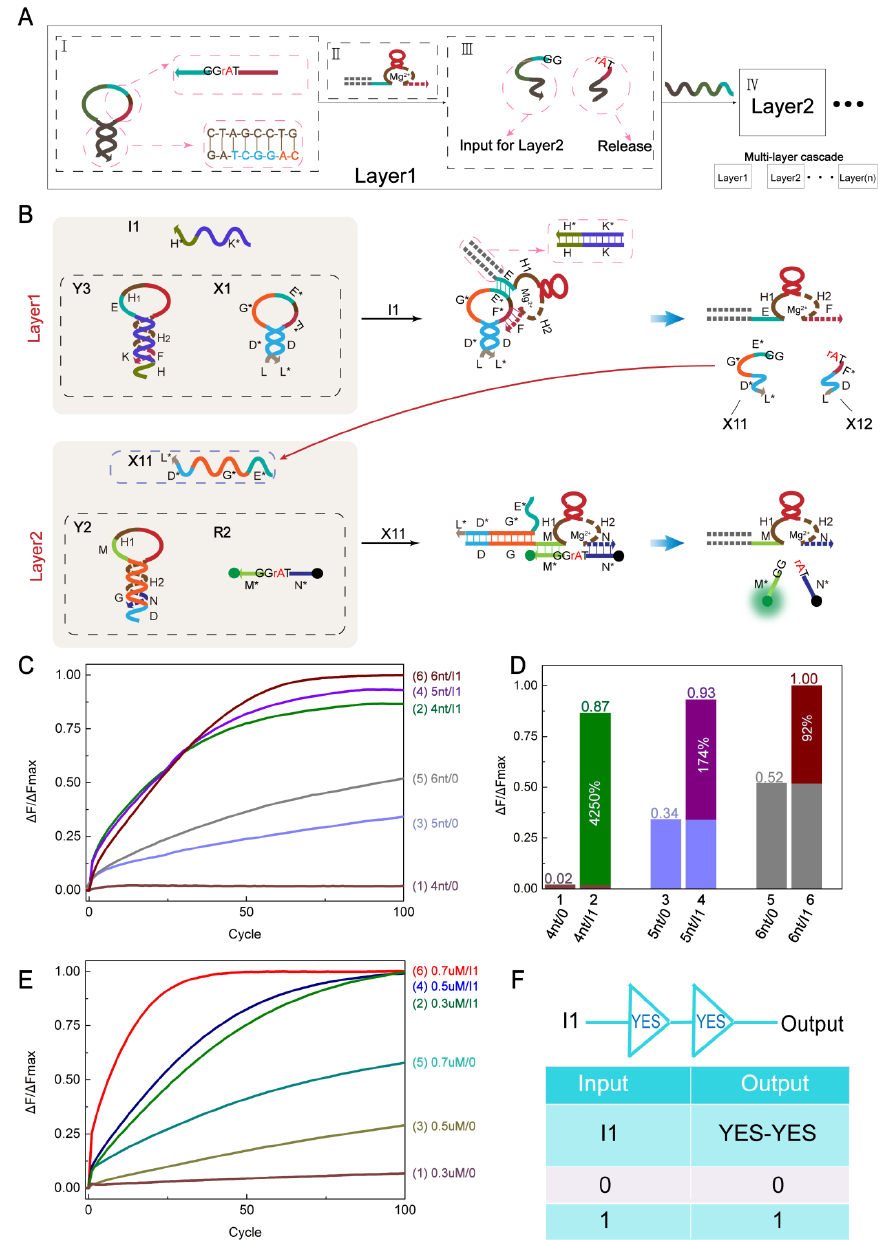
Figure 4. ( A ) Module design of controllable cascading logic circuit based on DNAzyme activity. ( B ) Schematic of the YES-YES logic circuit. ( C ) Time-dependent normalized fluorescence intensity change ( ∆ F / ∆ FMax) when the number of bases in the D domain of Y2 is di ff erent. Curves 1, 3, and 5 are changes in fluorescence intensity at no I1, with D domains of 4 nt, 5 nt, and 6 nt, respectively. Curves 2, 4, and 6 are the changes in fluorescence intensity in the presence of I1, corresponding to curves 1, 3, and 5, respectively. The sampling interval is 6 min, 100 cycles. All data represent the average of three replicates. ( D ) Statistical analysis of the number of bases of the D domain of Y2 in Layer2 (corresponding to Figure C). The percentage of relative fluorescence increase (( ∆ F(1) − ∆ F(0)) / ∆ F(0)%) is indicated in columns 2, 4, and 6. The reaction time is 10 h. ( E ) Time-dependent normalized fluorescence intensity change ( ∆ F / ∆ FMax) at di ff erent concentrations. Curves 1, 3, and 5 are fluorescence intensities without I1, with system concentrations of 0.3 µ M, 0.5 µ M, and 0.7 µ M, respectively. Curves 2, 4, and 6 are changes in fluorescence intensity in the presence of I1, corresponding to curves 1, 3, and 5, respectively. The substrate R2 concentration was fixed at 0.3 µ M. The sampling interval is 6 min, 100 cycles. All data represent the average of three replicates. ( F ) YES-YES logic circuit symbol and truth